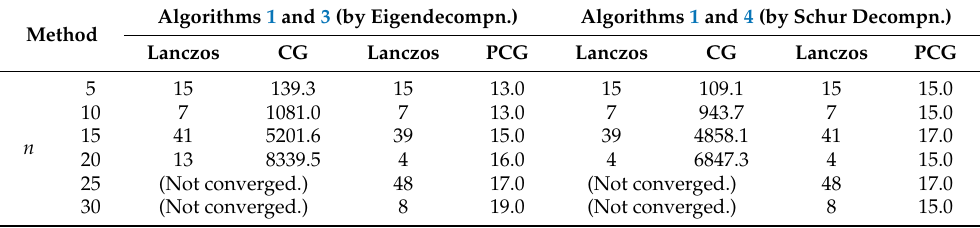
Table 2. Number of iterations of the Lanczos method and the average of numbers of iterations of the CG/PCG method in the case of the median of singular value of almost symmetric matrix T with a = c = 1 and b = 0.01 in (9) for the shift (8). Algorithms 1 and 3 (by Eigendecompn.) Algorithms 1 and 4 (by Schur Decompn.) Method